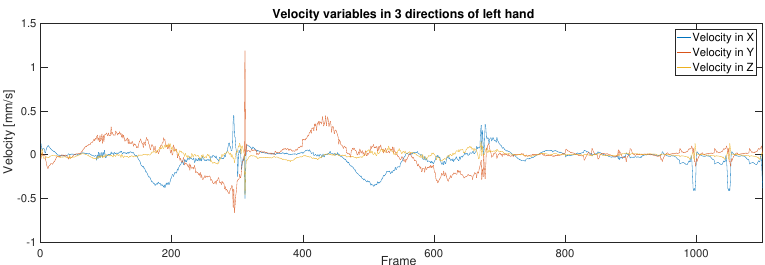
Figure 11. Motion velocity of the left hand of the human operator in 3 directions.